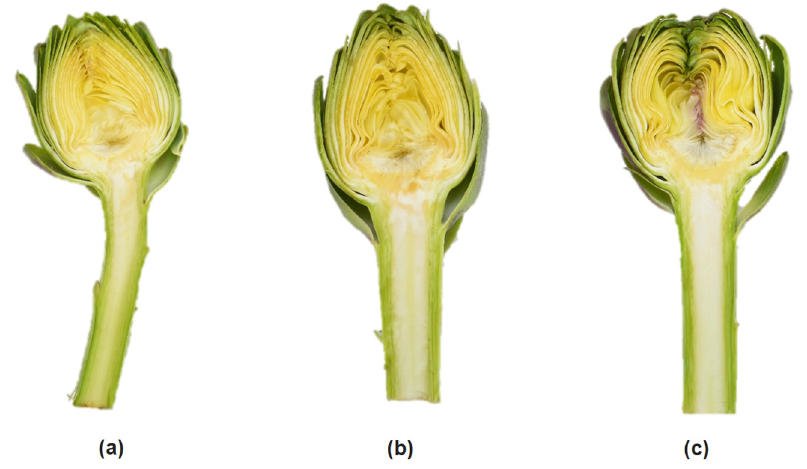
Figure 1. Scale of internal development stage: ( a ) initial development stage; ( b ) intermediate devel- opment stage; ( c ) advanced development stage.